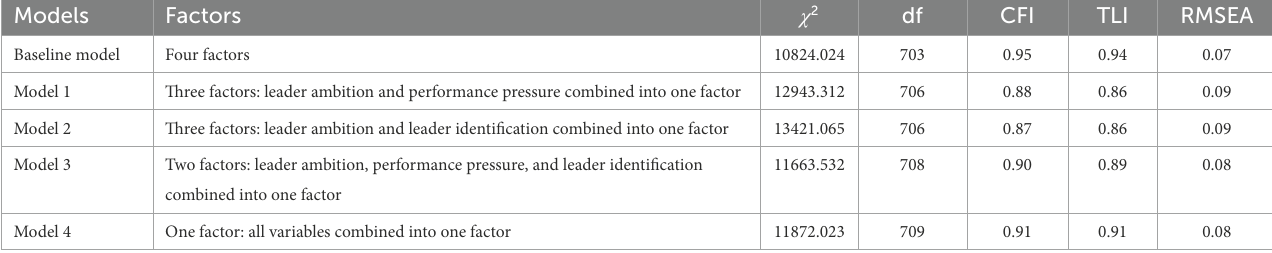
TABLE 4 Study 2- comparison of measurement models.